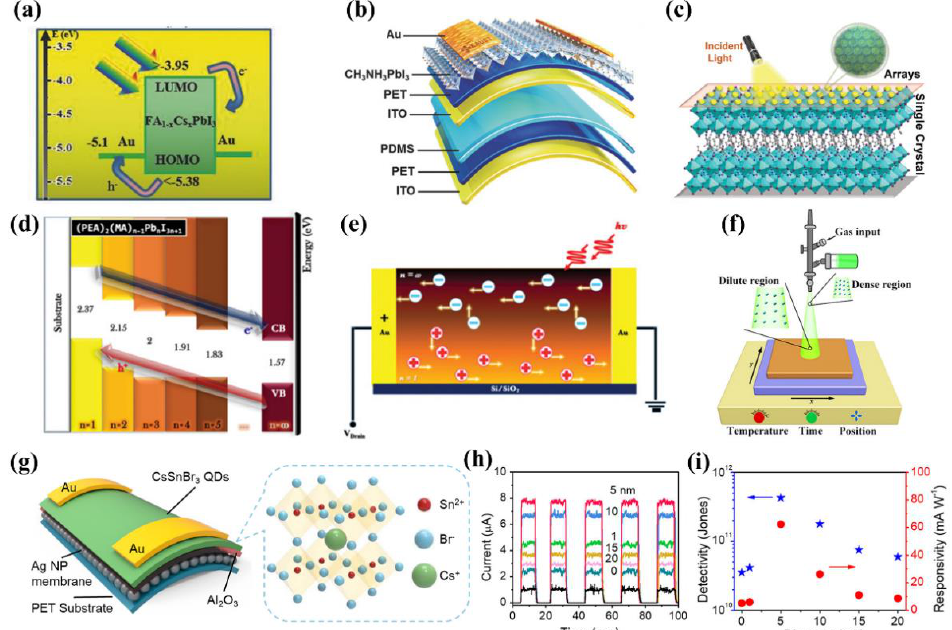
Figure 6. Schematic illustration of ( a ) the energy level of Cs-doped FAPbI 3 perovskite photodetector under incidental light, ( b ) the MAPbI 3 -based flexible photodetector, ( c ) the array photodetector based on (PA) 2 (G)Pb 2 I 7 . Schematic of ( d ) the energy band diagram and ( e ) charge transport in the gradient 2D/3D perovskite films. ( f ) Schematic illustration of the spray-coating deposition method. ( g ) Schematic of the PET/Ag NP/Al 2 O 3 /CsSnBr 3 QD photodetector. ( h ) Photocurrent of the photodetectors with different thicknesses of the Al 2 O 3 layers. ( i ) The detectivity and responsivity of photodetectors with different thicknesses of the Al 2 O 3 layers. ( a ) Reprinted with permission from Ref. [29].